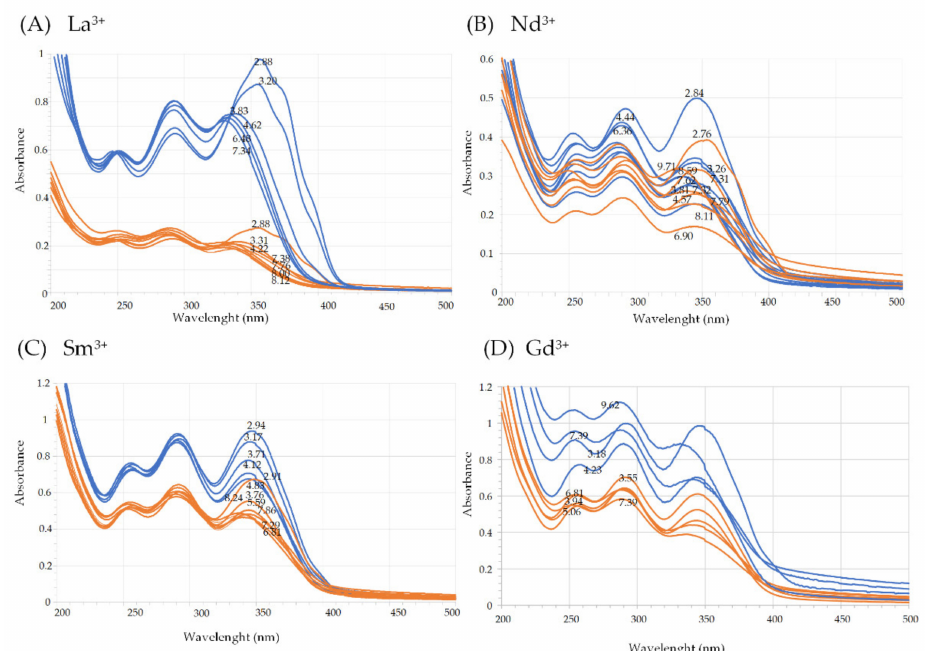
Figure 3. Raw UV–Vis spectra of ( A ) solutions of La 3+ and harzianic acid, ( B ) solutions of Nd 3+ and harzianic acid, ( C ) solutions of Sm 3+ and harzianic acid, and ( D ) solutions of Gd 3+ and harzianic acid with accurately known analytical composition and pH (= − log[H + ]). For each metal cation, absorption spectra define two sets differentiated by color: orange-colored spectra were acquired on solutions with nearly equal concentration of the ligand and metal; blue spectra were acquired on solutions with concentration of the ligand nearly twice that of the metal cation. Numerical labels on curves indicate the corresponding pH. Details on ligand and metal concentrations employed to collect the UV–Vis spectra are reported in Table 2 for